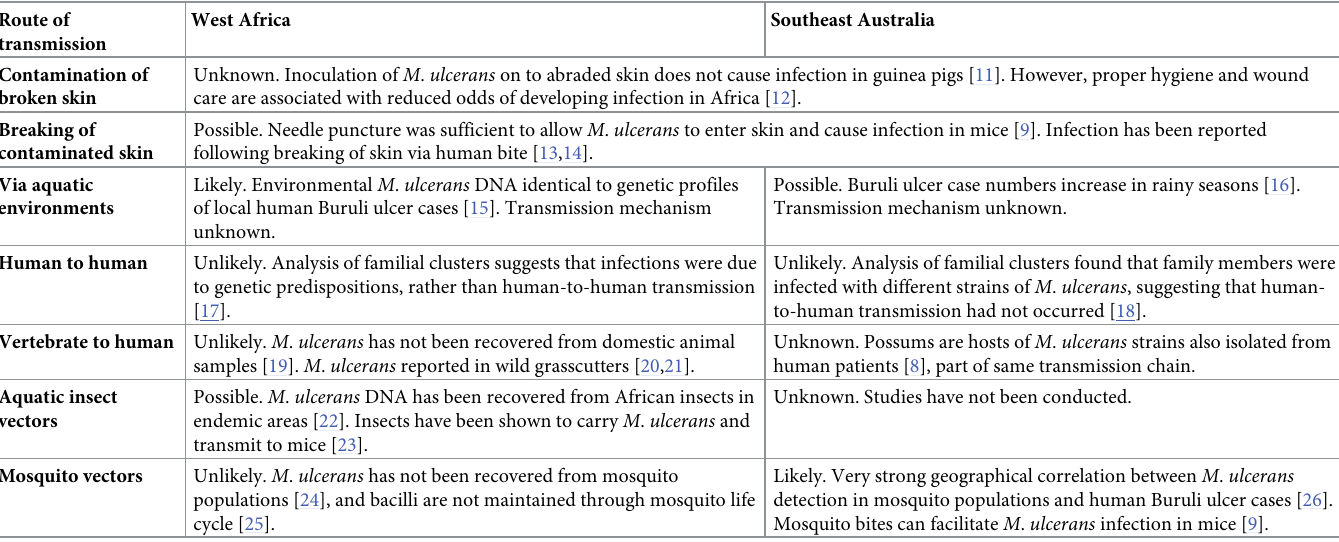
Table 1. Summary of current evidence regarding proposed routes of transmission of Mycobacterium ulcerans in West Africa and Southeast Australia. Route of